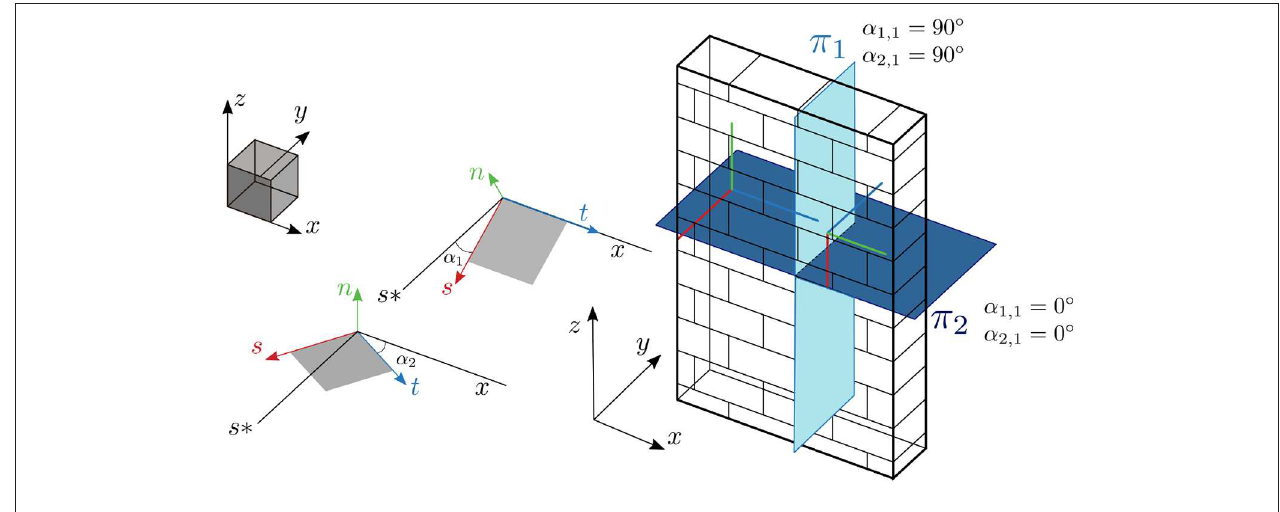
FIGURE 2 | JMM bed and head joint plane orientation.